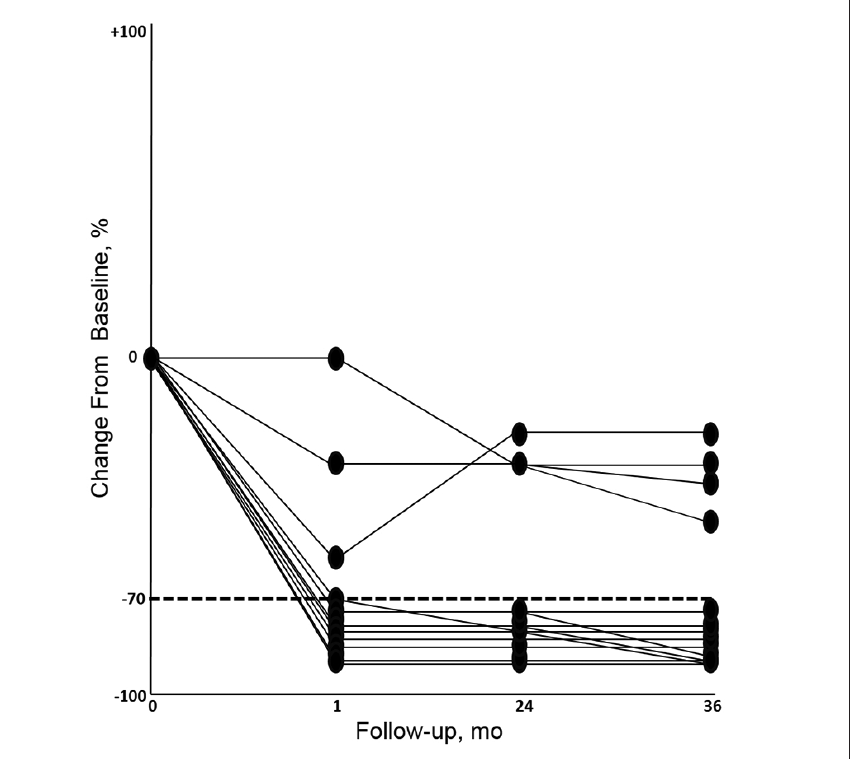
Figure 1. Response rate of VAS score before and after tonsillectomy in 17 patients. Thirteen patients with ≥70% improvement in their VAS scores maintained the same good condition at ≥36-month post-tonsillectomy, whereas four patients with <70% improvement in their VAS scores did not show remarkable improvement after that time point